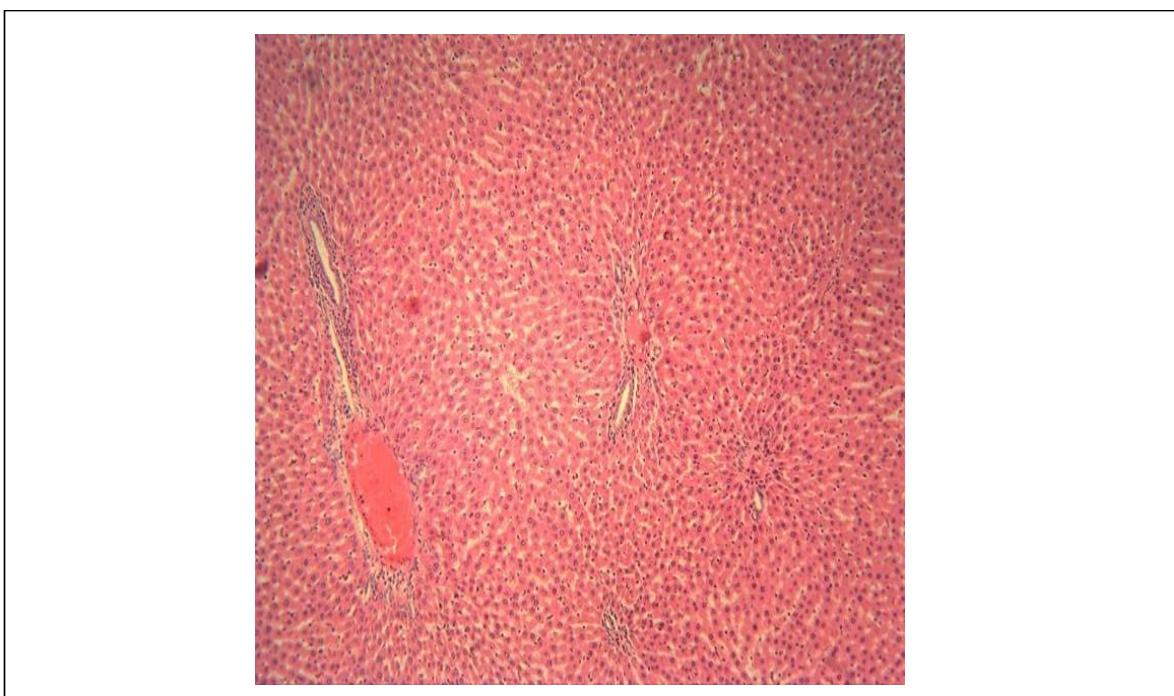
Plate 3: Effect of methanol extract of N. laevis on the liver of group C rats exposed to 600 mg/kg + 8,000 mg/kg of MSG